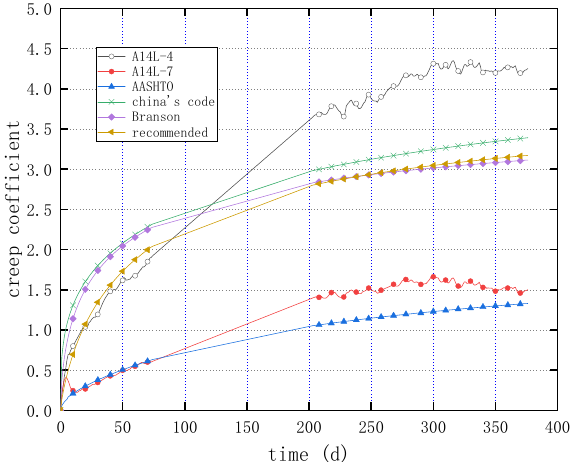
Figure 20. Evolution of creep coefficients of specimens via various approaches (loading age of 7 days).